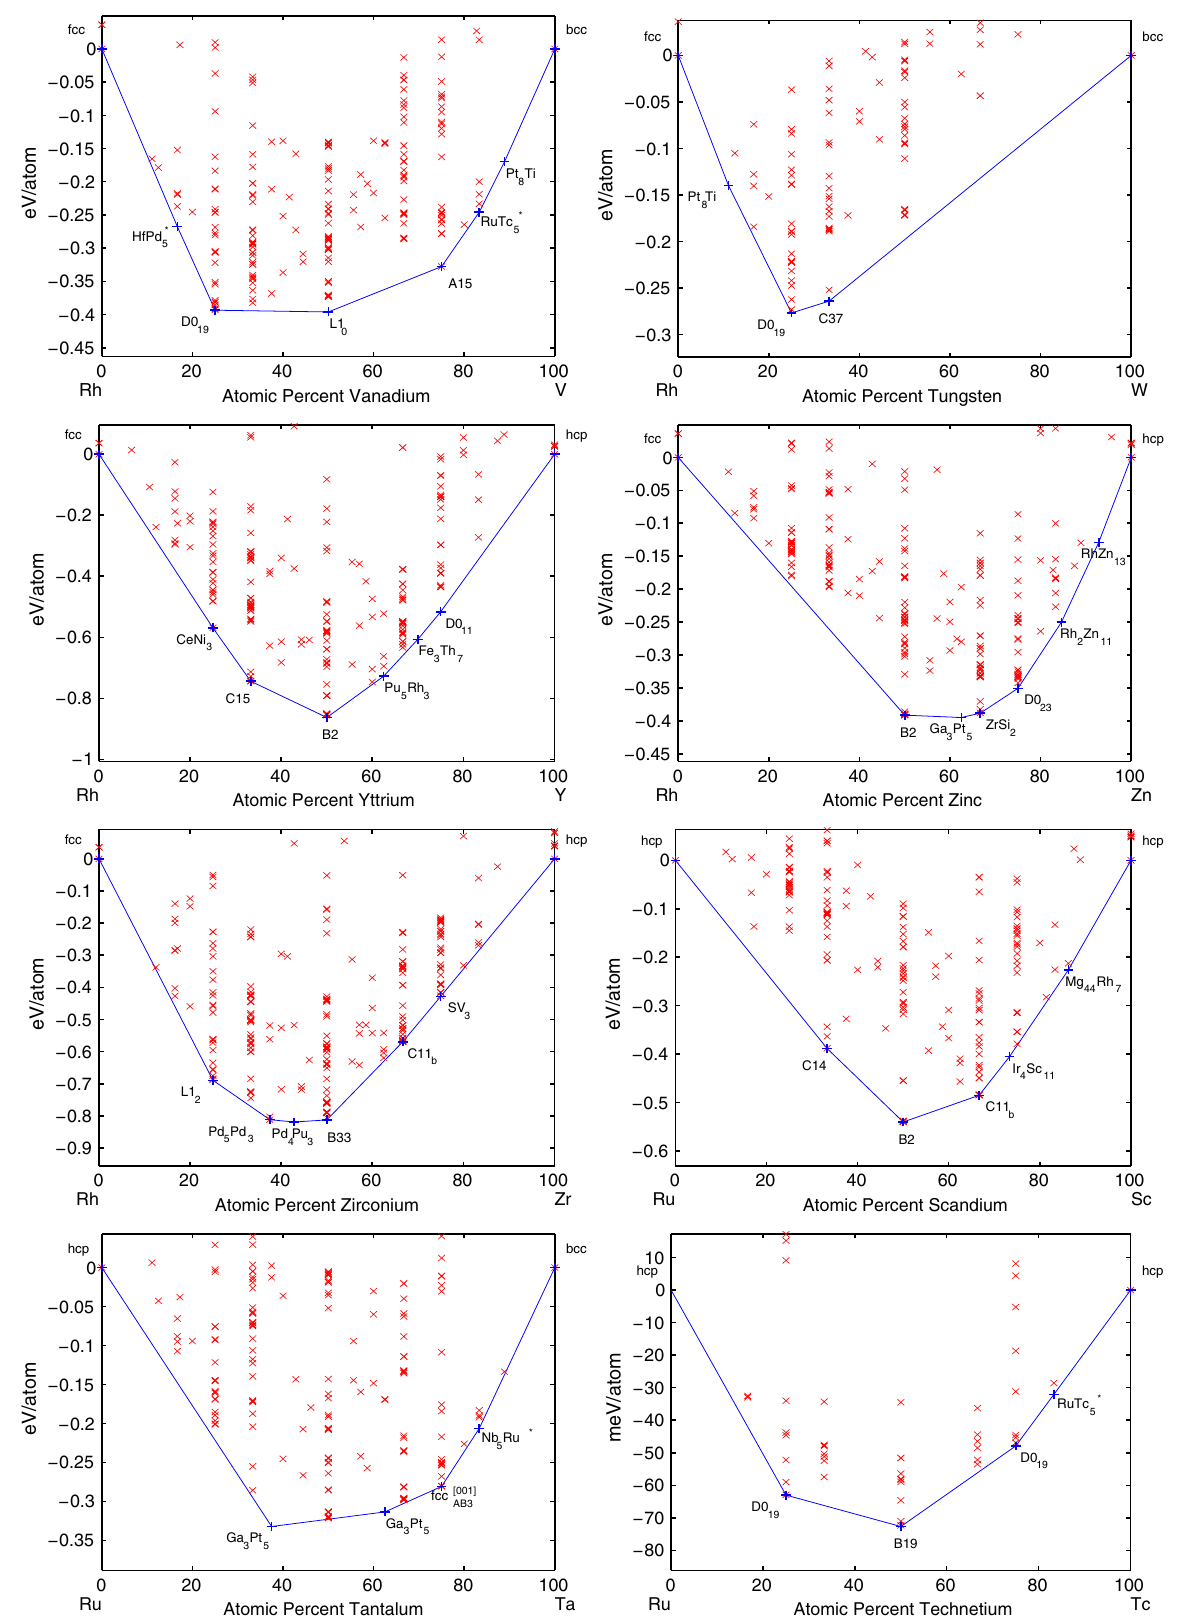
FIG. 18. Convex hulls for the systems Rh-V, Rh-W, Rh-Y, Rh-Zn, Rh-Zr, Ru-Sc, Ru-Ta, and